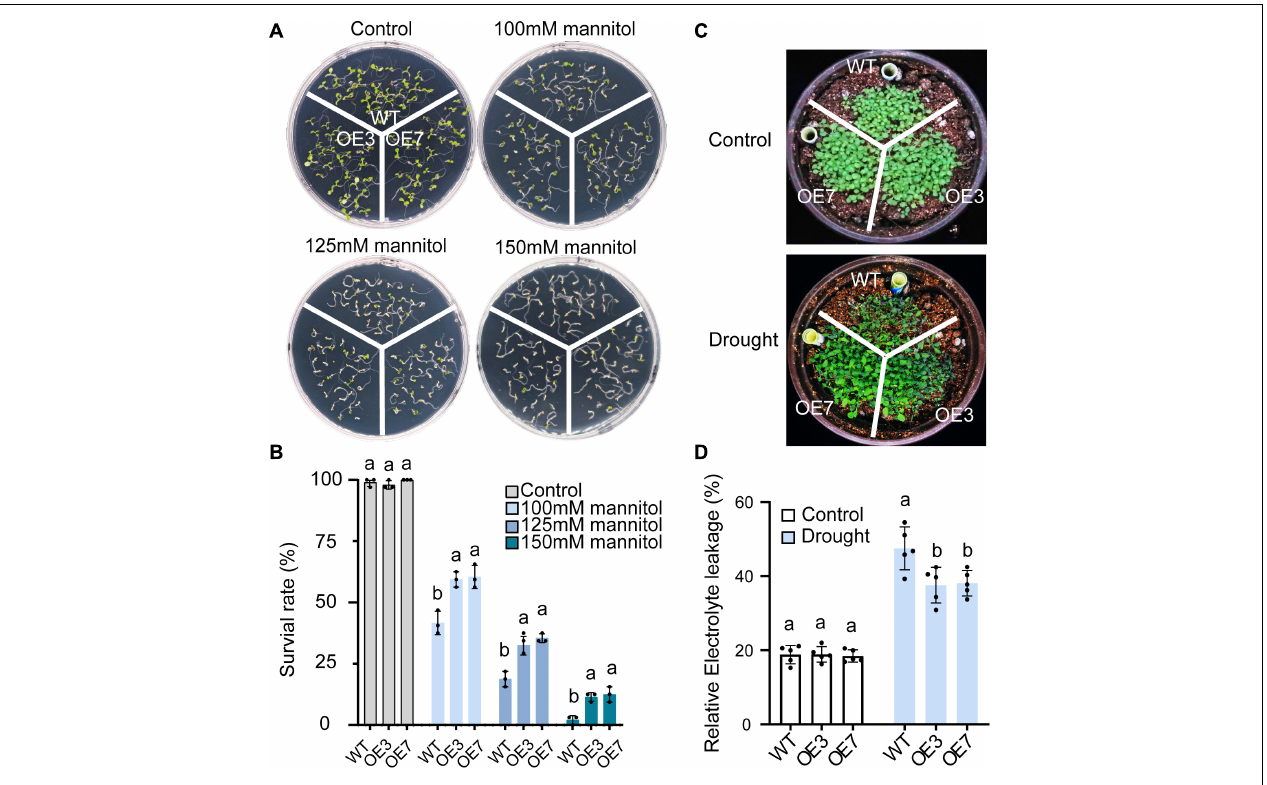
FIGURE 3 | Overexpression of CsGSTU8 improves drought stress tolerance in transgenic Arabidopsis . (A) Growth phenotypes under control and mannitol conditions in MS media. (B) Measurement of survival rate in MS media. The Data are presented as the means ± SDs of three independent experiments. (C) Growth phenotypes under control and drought stress conditions in the soil. (D) Measurement of relative electrolyte leakage. The Data are the means ± SDs of five independent experiments. The Values not followed by the same letter are significantly different according to Duncan’s multiple range test ( P <